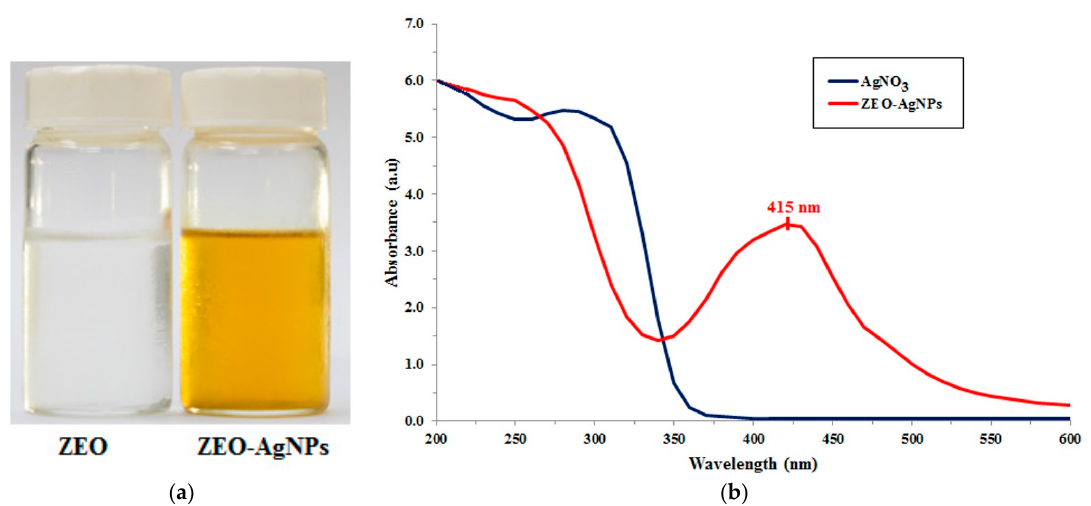
Figure 1. Preparation procedure of AgNPs, and UV/VIS spectroscopy. ( a ) The reactant before and then the product after the reaction. ( b ) UV/VIS spectroscopy of AgNPs. The maximum absorption peak of ZEO-AgNPs was 415 nm.